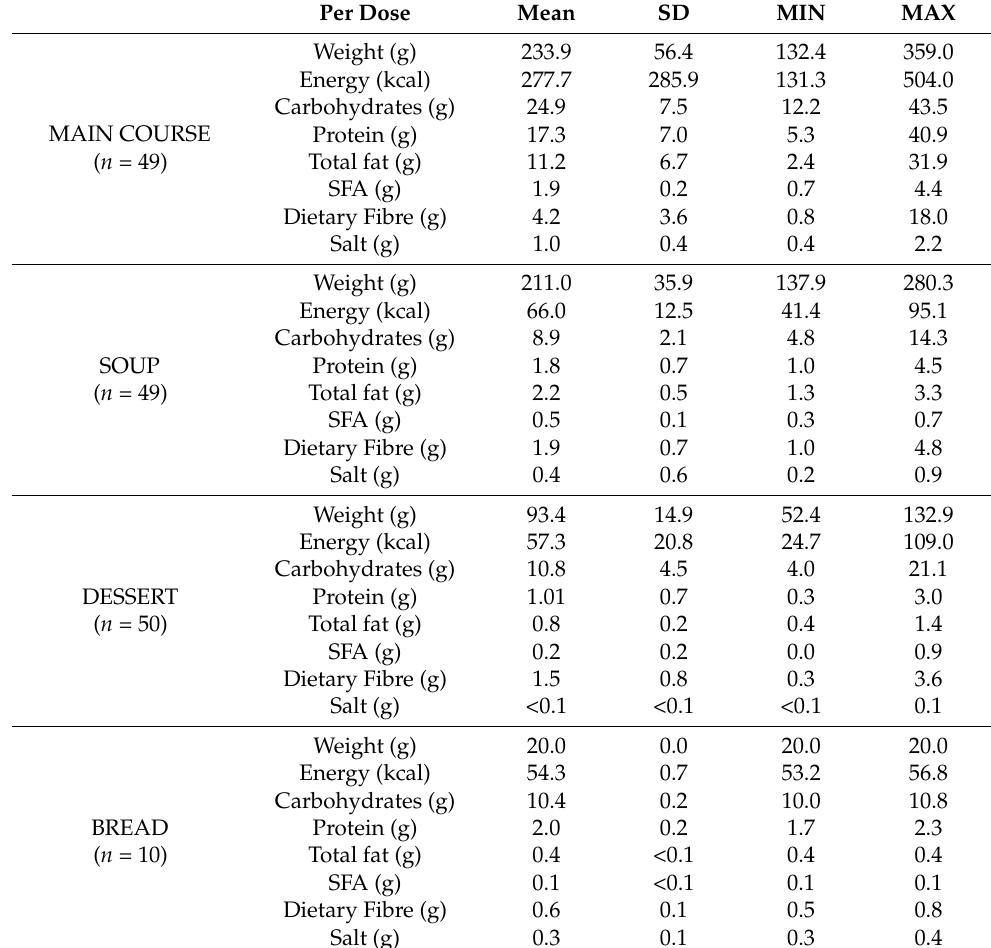
Table 2. Weight and nutritional composition of main course, soup, dessert, and bread of school lunches